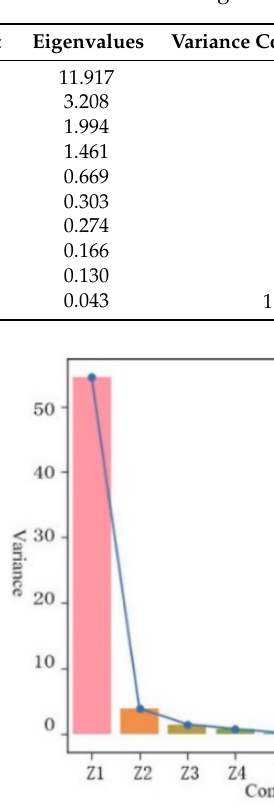
Table 1. Eigenvalues and contribution.